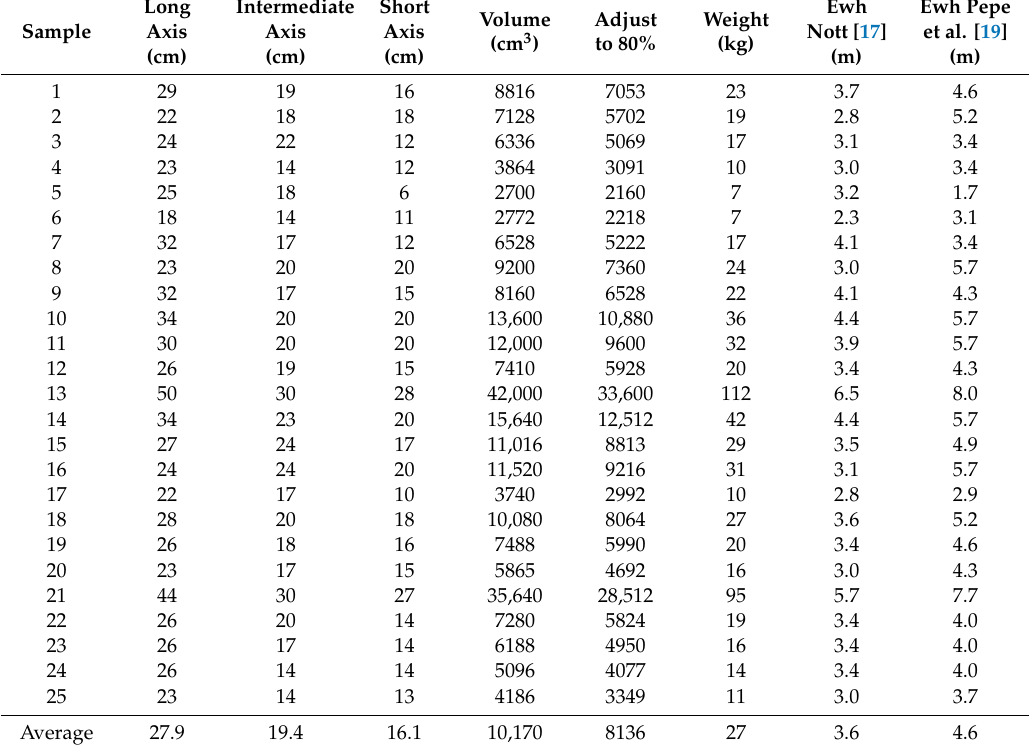
Table A1. Quantification of clast size, volume, and estimated weight from a sample on the SW flank of Støypet (locality 1). The density of low-grade chromite at 3.32 g / cm 3 is applied uniformly in order to calculate wave height for each boulder. Abbreviation: EWH = estimated wave